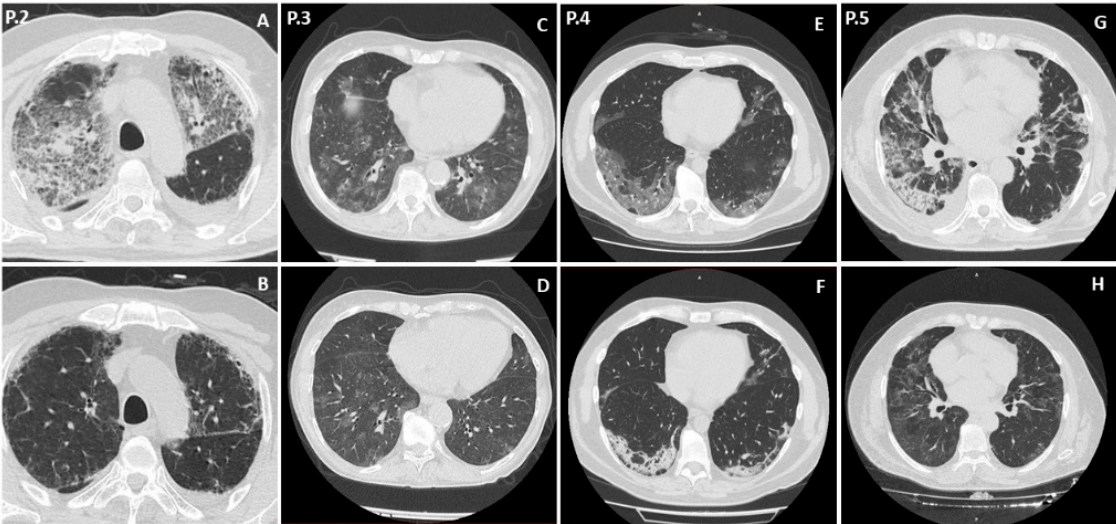
Figure 1. Radiological characteristics of the patients. Patient 2 (P.2): ( A ) HRCT at PJP diagnosis; ( B ) HRCT after CTX therapy, 21 days after PJP diagnosis. Patient 3 (P.3): ( C ) HRCT at PJP diagnosis; ( D ) HRCT after CTX therapy, 30 days after PJP diagnosis. Patient 4 (P.4): ( E ) HRCT at PJP diagnosis; ( F ) HRCT after CTX therapy, 20 days after PJP diagnosis. Patient 5 (P.5): ( G ) HRCT at PJP diagnosis; ( H ) HRCT after CTX therapy, 26 days after PJP diagnosis. HRCT = high-resolution CT-scan; PJP = Pneumocystis jirovecii pneumonia; CTX =